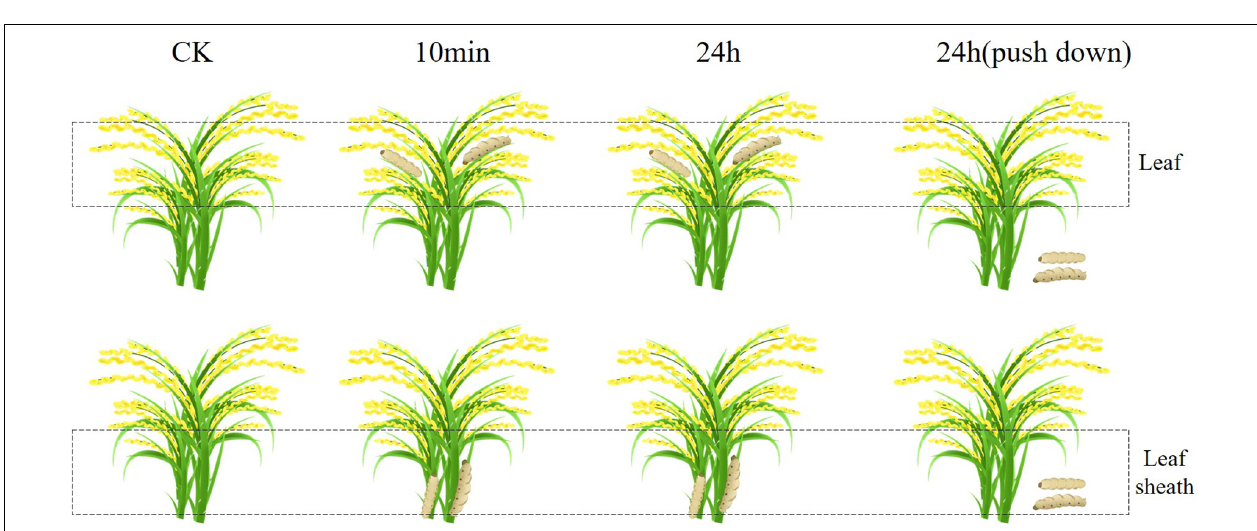
FIGURE 6 | The experimental setup. Three treatments (T1, T2, and T3) were set to study the responses of rice under C. suppressalis